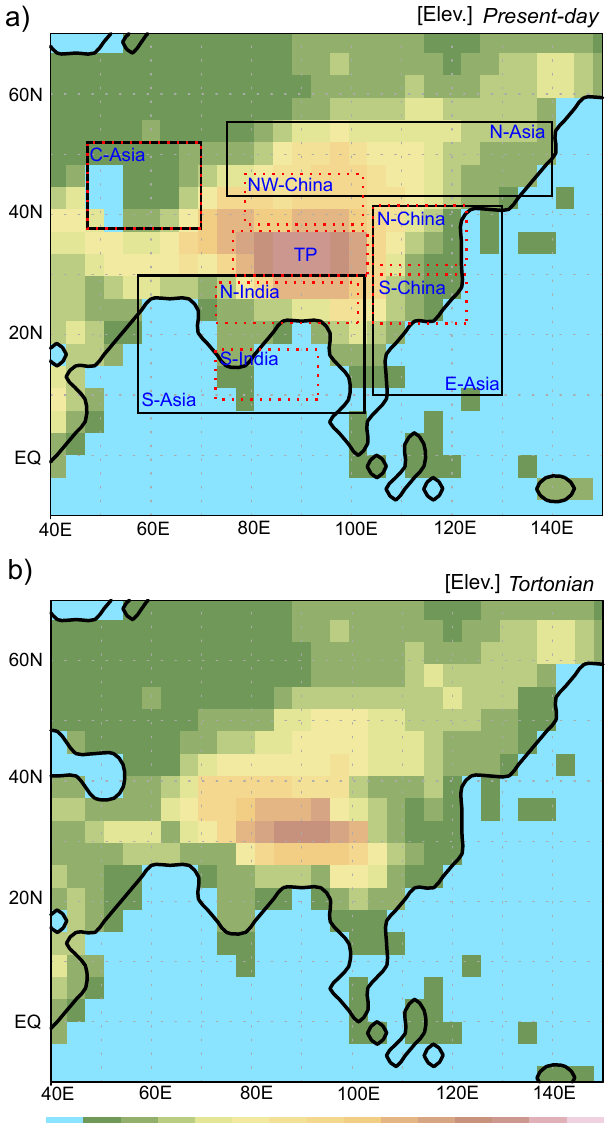
Fig. 1. The orography for the present-day control run (a) and the Tortonian run (b) of the global model. Black rectangles in (a) define the large regions referred to in the text. C-Asia: Central Asia; N- Asia: North Asia; E-Asia: East Asia; S-Asia: South Asia. The regions of major interest in this study are denoted by red dotted rectangles. TP: Tibetan Plateau; N-India: northern India; S-India: southern India; NW-China: northwestern China; N-China: northern China; S-China: southern China. N-China and S-China together are referred to as E-China (eastern